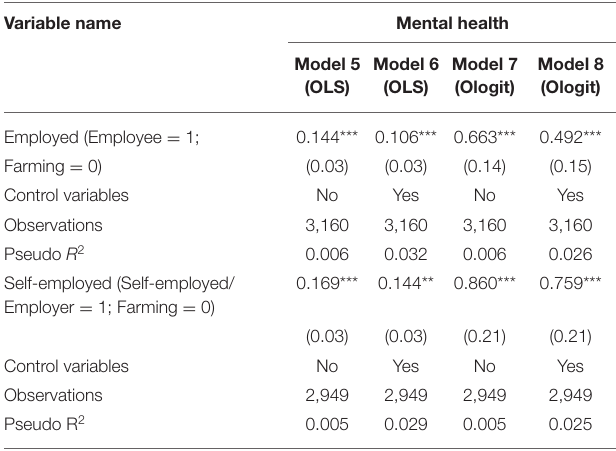
TABLE 3 | Basic regression results: different types of non-agricultural employment.